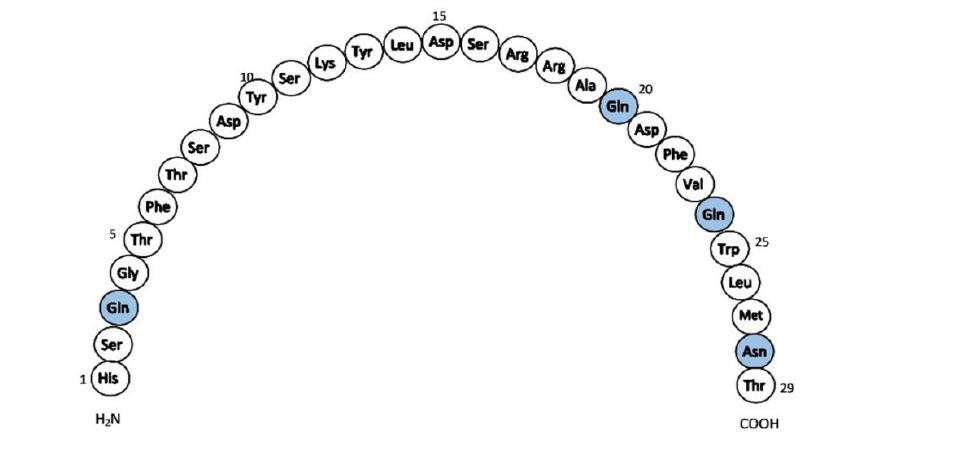
Figure 1. Amino acid structure of glucagon. Blue shaded sites are susceptible to deamidation modification.